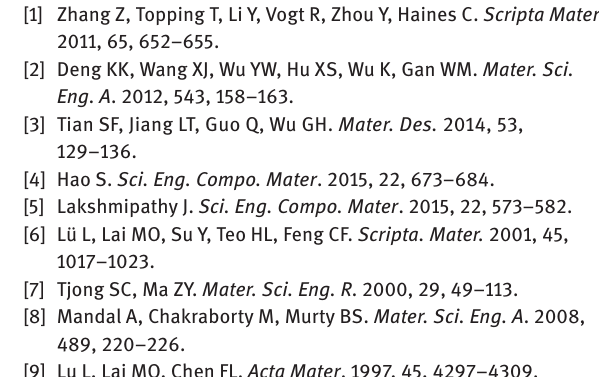
Figure 8: The comparison of yield strength prediction by the modified model with experimental data for TiB study; (B) deriving from